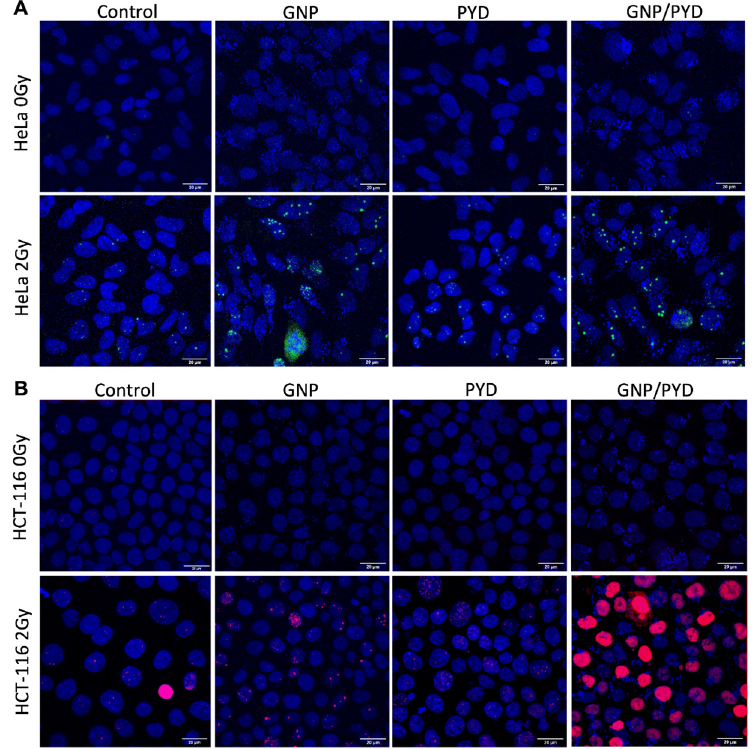
Figure 7. Mapping of DNA DSBs 24 h post irradiation to evaluate the triple combination of RT/GNP/PYD. ( A , B ) Qualitative assessment of DNA DSBs for HeLa and HCT-116, respectively. Cells were irradiated at 6 MV with a dose of 2 Gy and treated with GNPs and PYD at a concentration of 7.5 µg/mL and 500 nM, respectively. Scale bar = 20 µm. 53BP1 and γ H2AX foci appear as green and red dots, respectively and cellular nuclei are shown in blue after DAPI staining.